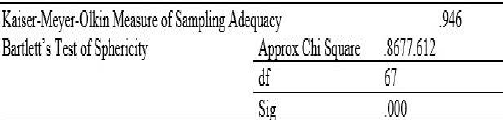
Table 1: KMO and Bartlett's Test for POS-Career Questionnaire